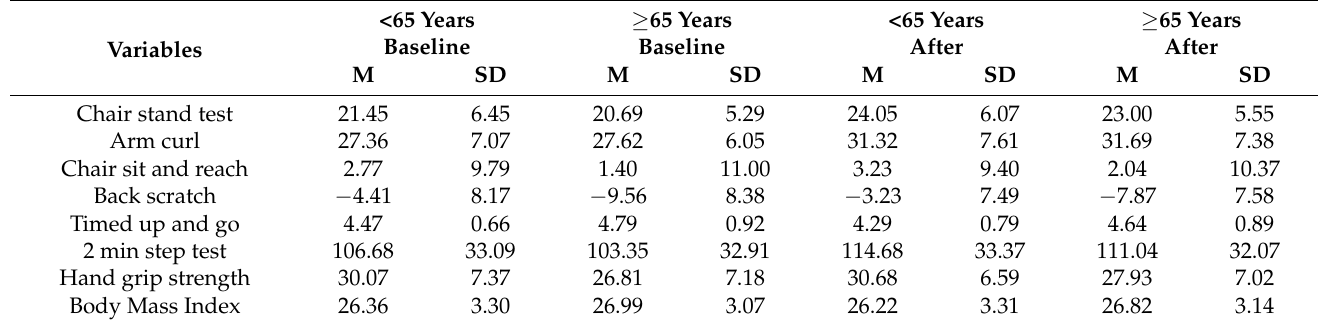
Table 2. Descriptive statistics of each group at baseline and after exercise program.